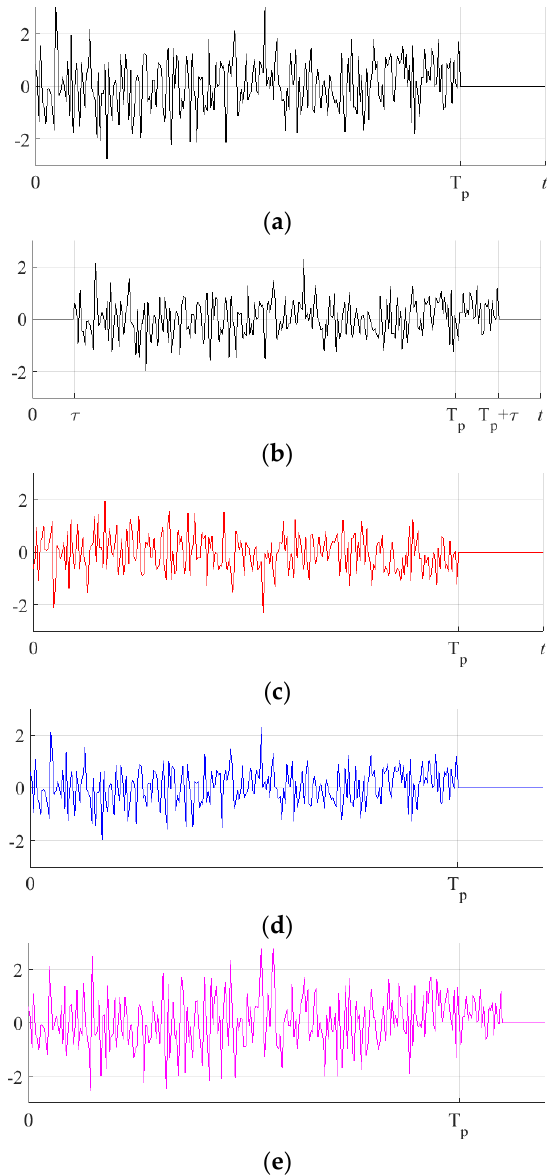
Figure 4. DC 2 scheme. Signal waveforms in various nodes of transmitter: ( a ) generated chaotic pulse; ( b ) reference chaotic pulse delayed by τ; ( c ) chaotic pulse modulated by signal “−1”; ( d ) chaotic pulse modulated by signal “1”; ( e ) Sum of signals ( b , c ).